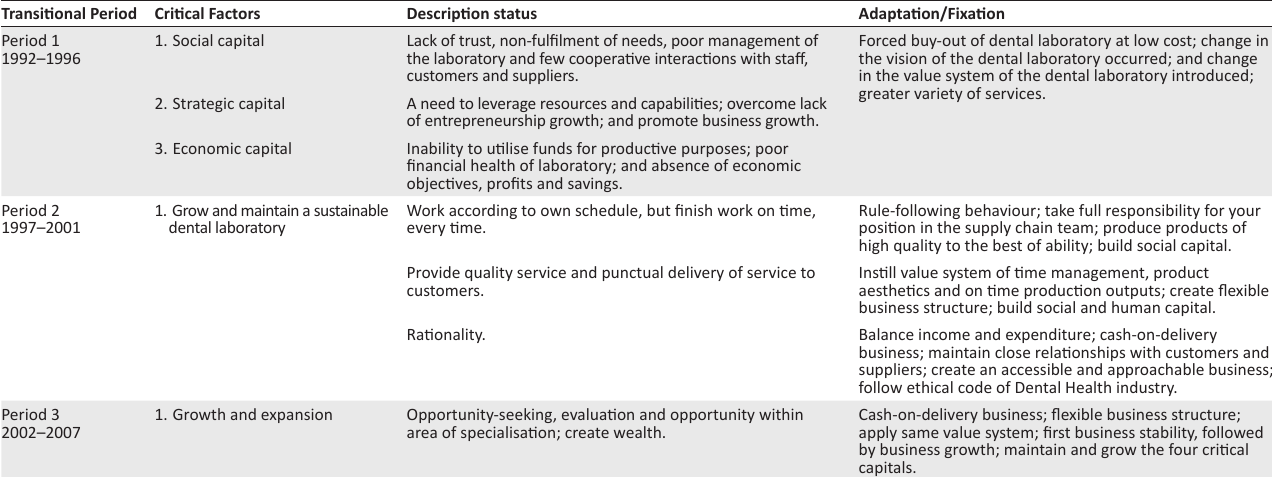
TABLE 1: Critical factors causing